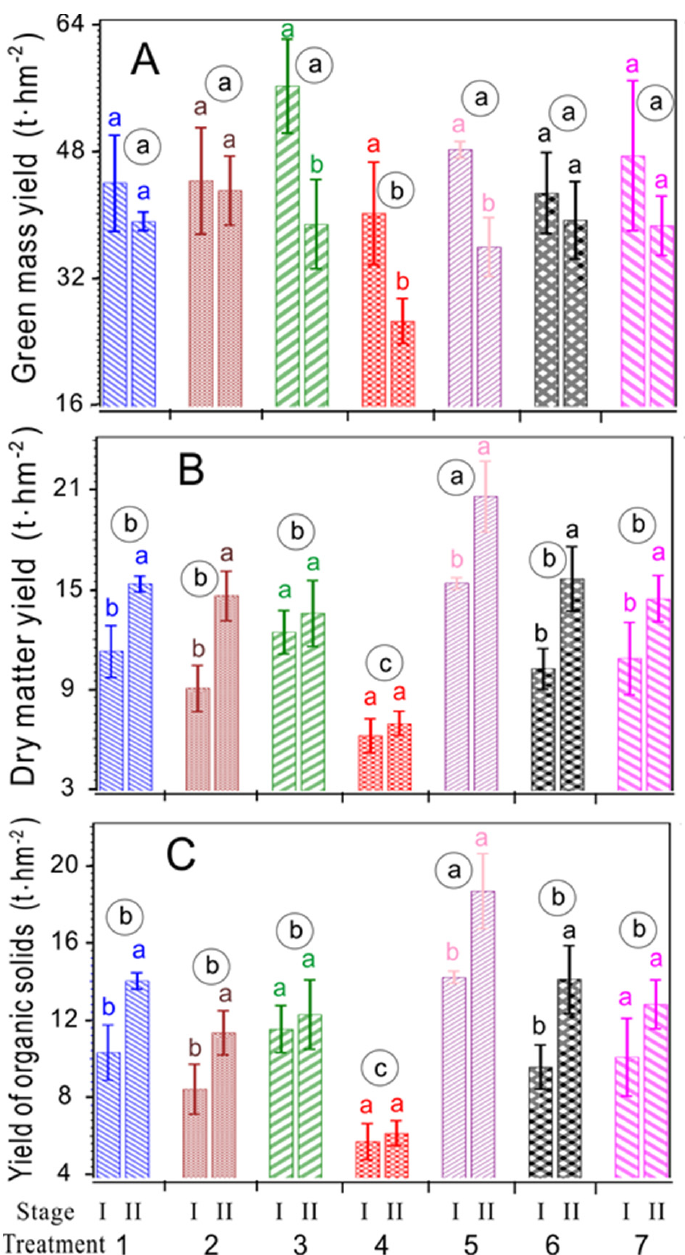
Figure 1. Yields of green mass ( A ), dry matter ( B ) and organic solids ( C ). The different lower letters in the circle indicated the difference among the treatments; the different colored lower letters indicate the difference between harvested stages I and II in their treatment. n = 4. Treatments include: 1: pure oat; 2: 50% winter pea:50% oat; 3: 75% winter pea:25% oat; 4: pure winter pea; 5: pure triticale; 6: 50% winter pea:50% triticale; 7: 75% winter pea:25% triticale. Stages include: 1. full-flowering stage of winter pea and beginning of milky stage of cereals and 2. emergence of firsts pods for pea and milky/waxy stage of cereals.